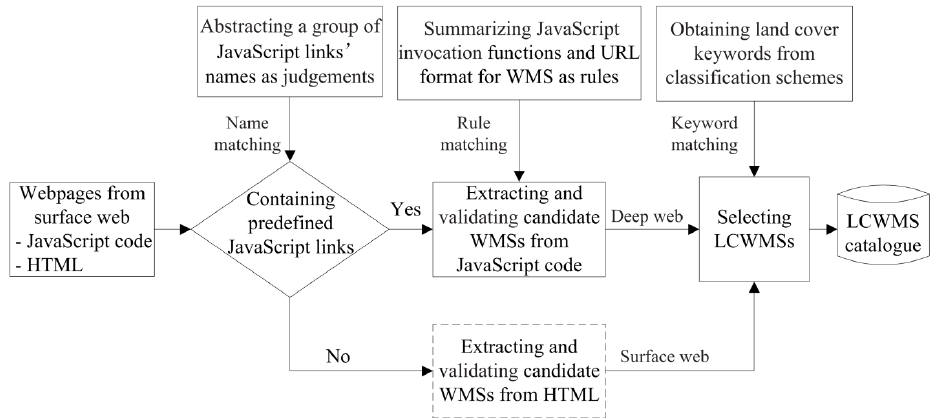
Figure 1. The conceptual framework for discovering LCWMSs. Table 1. Reference formats of the four WMS-related JavaScript libraries.